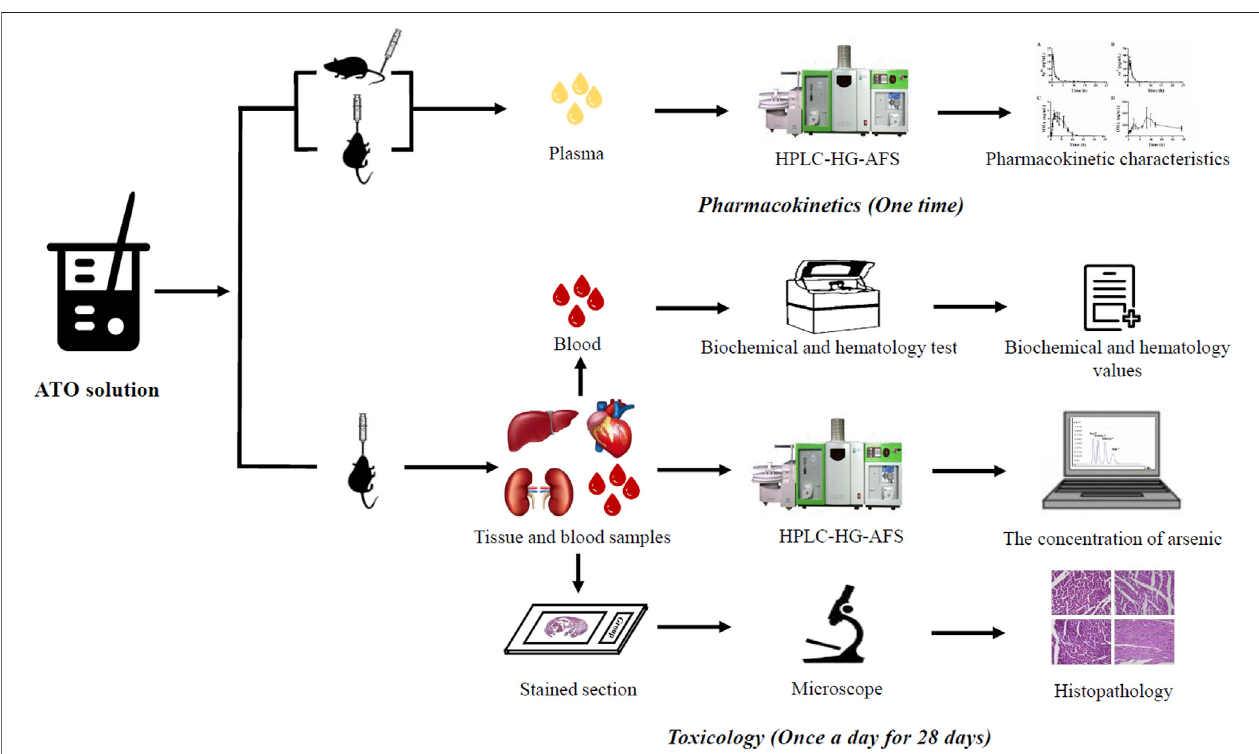
FIGURE 1 | Pharmacokinetics and toxicology study in rats administered with oral